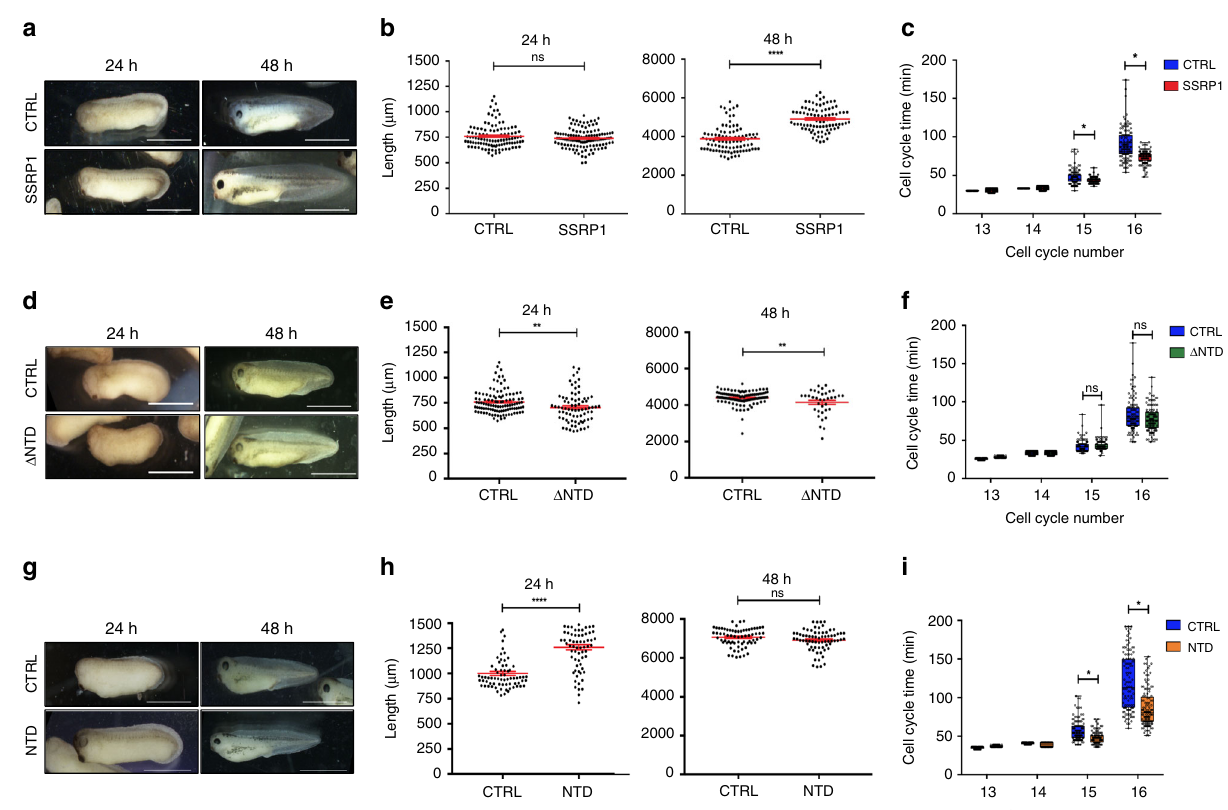
Fig. 7 SSRP1 induced development acceleration through cell cycle shortening. a Representative images of control buffer (CTRL) and Myc-SSRP1 (SSRP1) injected Xenopus laevis embryos at 24 and 48 hours pf. Size bar = 1000 µ m. b Graph showing lengths of CTRL and SSRP1- injected embryos measured 24 and 48 h pf. Each point represents one embryo. Bars show mean ± SEM; **** p < 0.0001; ns = not signi fi cant; n = 120 embryos; unpaired two-tailed t test. c Graph showing average length of cell cycle post-MBT per embryo measured for 30 cells starting at the 12th cell division using four embryos for each indicated condition. Cell cycle duration times between two sequential divisions were manually annotated from movies; n = 120 cell cycles; * p < 0.01; unpaired two-tailed t -test. d Representative images of CTRL and Myc- Δ NTD — injected embryos at 24 and 48 h post-fertilization. Size bar = 1000 µ m. e Graph showing length of CTRL and Myc- Δ NTD mRNA injected embryos measured 24 and 48 h pf. Each point represents one animal. Bars show mean ± SEM; n = 100 embryos; ** p < 0.01; unpaired two-tailed t test. f Graph showing average duration of cell cycle post-MBT measured as in ( c ); n = 120